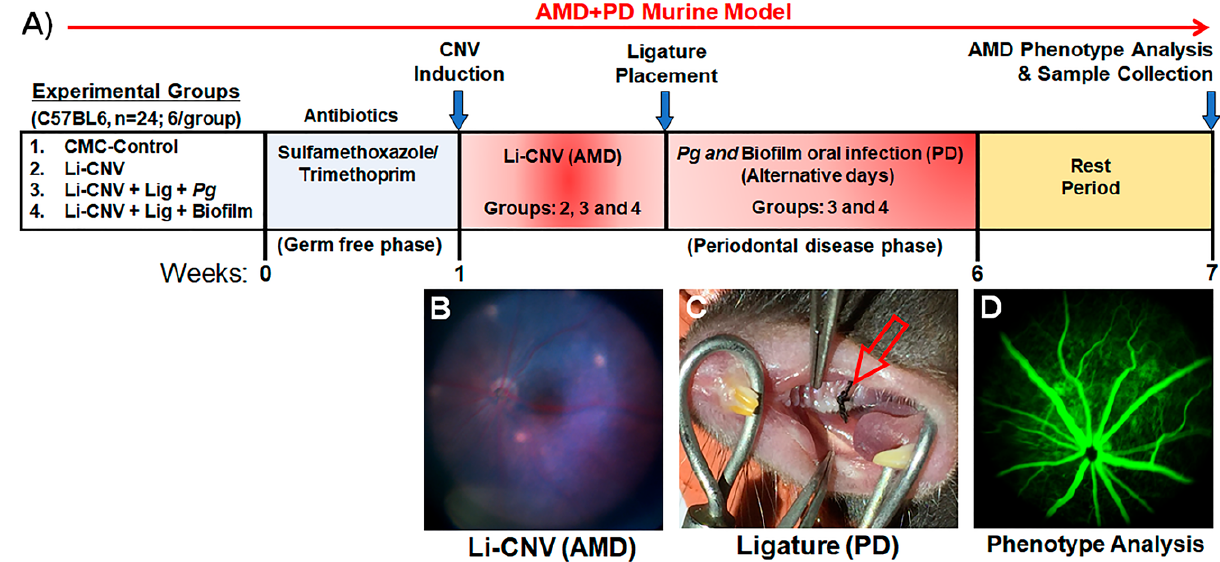
Figure 1. Study design and establishment of unique age-related macular degeneration (AMD)+ periodontal disease (PD) murine model. ( A ) Shows the complete experimental design involving four groups 1. CMC ( − ve ) control, 2. Laser-induced choroidal neovascularization (Li-CNV), 3. Li-CNV+Lig+Pg, and 4. Li-CNV+Lig+Biofilm (detailed in the methods section). ( B , C ) Establishment of unique AMD+PD murine model. After laser induction, mice were ligated followed by Pg or biofilm infection and AMD+PD model established. Representative image demonstrating the laser induction ( B ), ligature placement around the second maxillary molar ( C -red arrow), and systematic noninvasive fundus fluorescein angiography (FFA) ( D ) for AMD phenotype analysis.